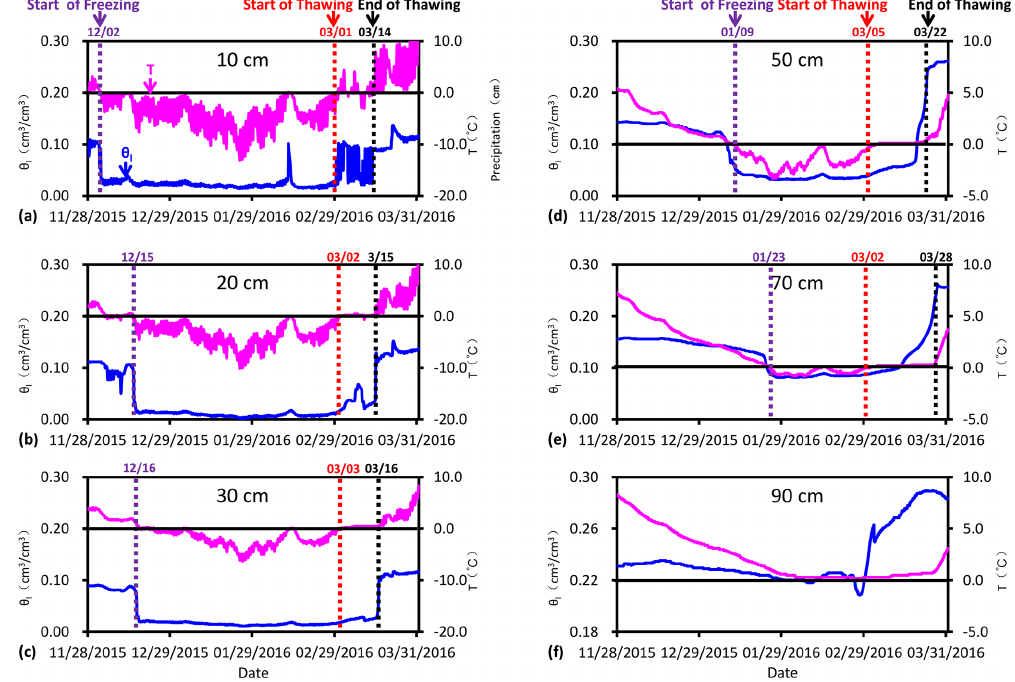
Figure 4. The observed hourly liquid water content and soil temperatures during the freezing–thawing cycle from 28 November 2015 to 1 April